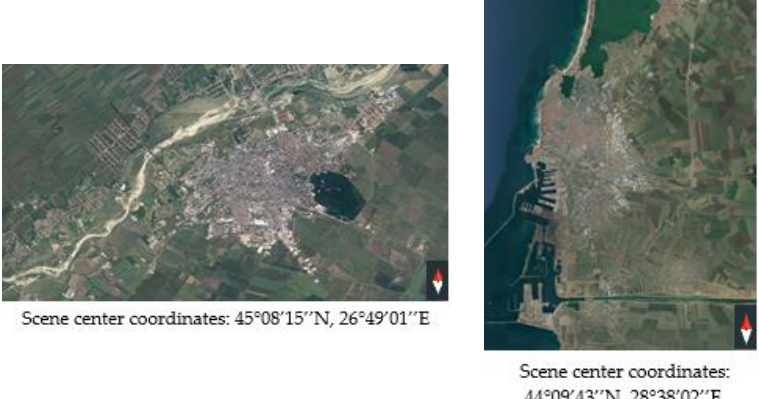
Figure 3. Optical view of Buzău ( A ) and Constanța ( B ) test regions (© Google Earth).